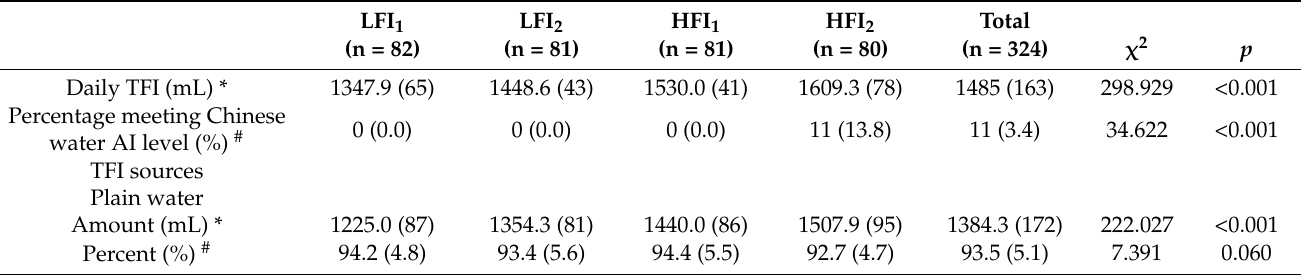
Table 3. Composition of fluid intake of participants with different TFI